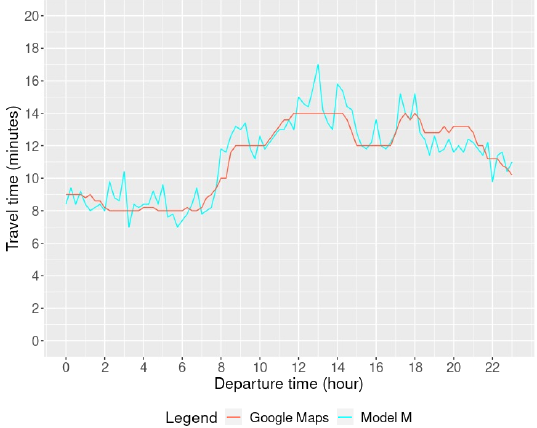
Figure 12. Route travel time on Queen St W (east direction), Toronto (Road type: secondary, route length: 4.20